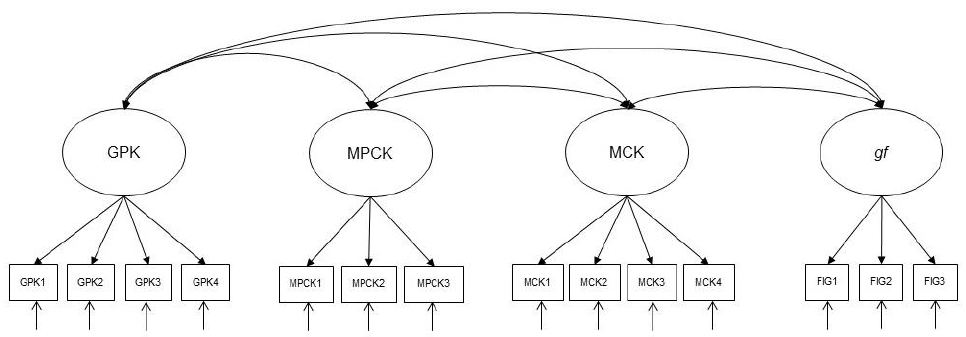
Figure 1. The latent correlation model (H2). Note. MCK = mathematics content knowledge; MPCK = mathematics pedagogical content knowledge; GPK = general pedagogical knowledge; gf = fluid intelligence.